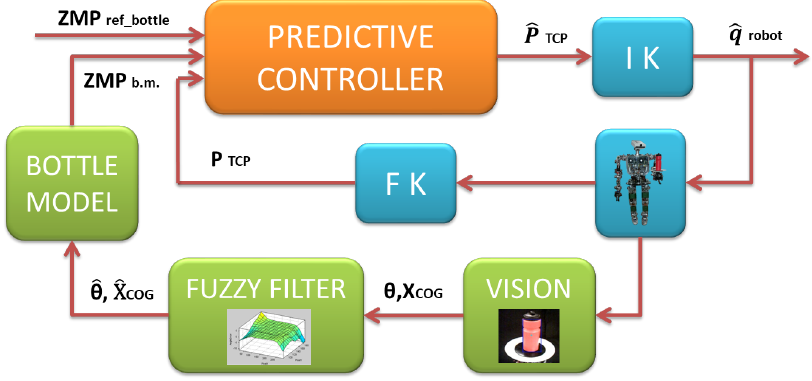
Figure 3. Control of the equilibrium of a bottle on a tray in a Non-Grasping